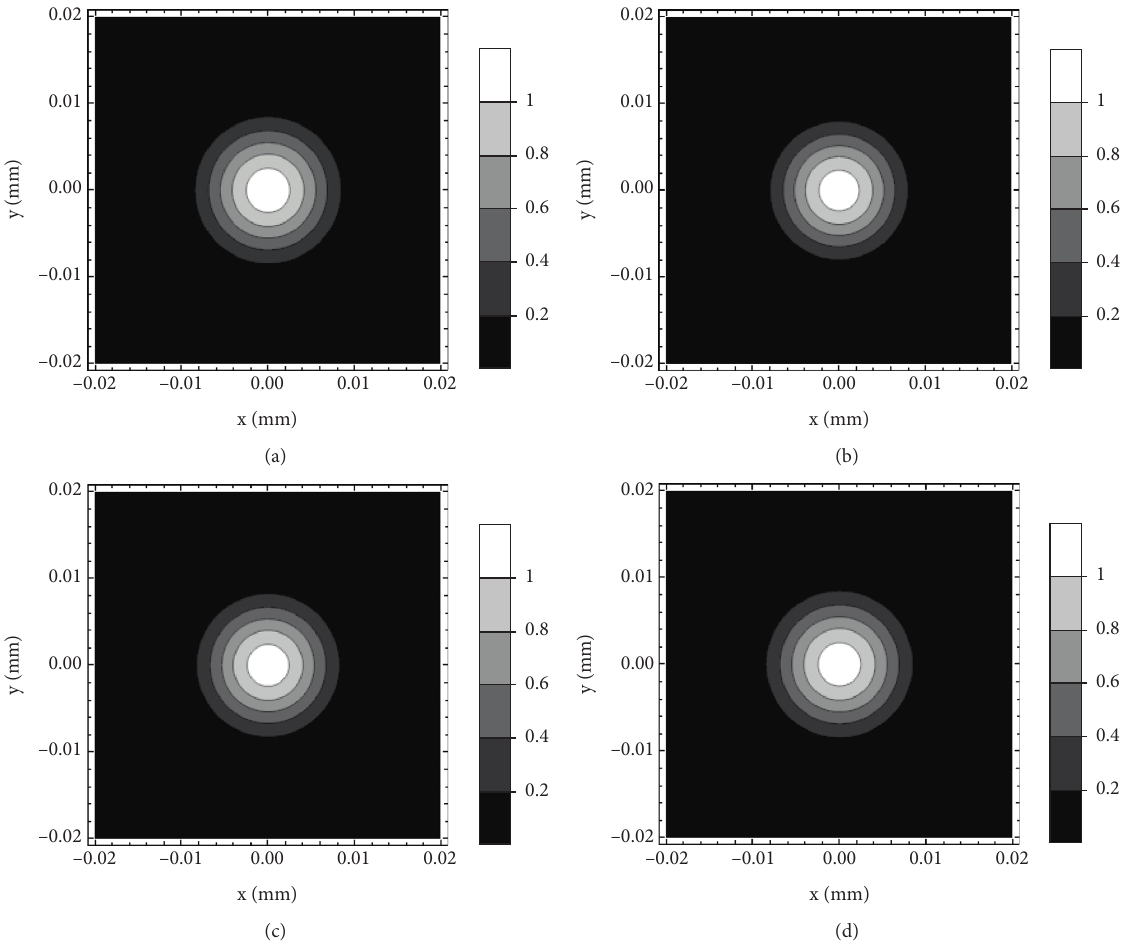
Figure 3: Intensity patterns of the partially coherent Lorentz beam with incident beam widths of w with coherence widths σ � 8mm at different propagation distances in along focal length of logarithmic axicon. (a) z � 100mm. (b) z � 140 mm. (c) z � 180 mm. (d) z �